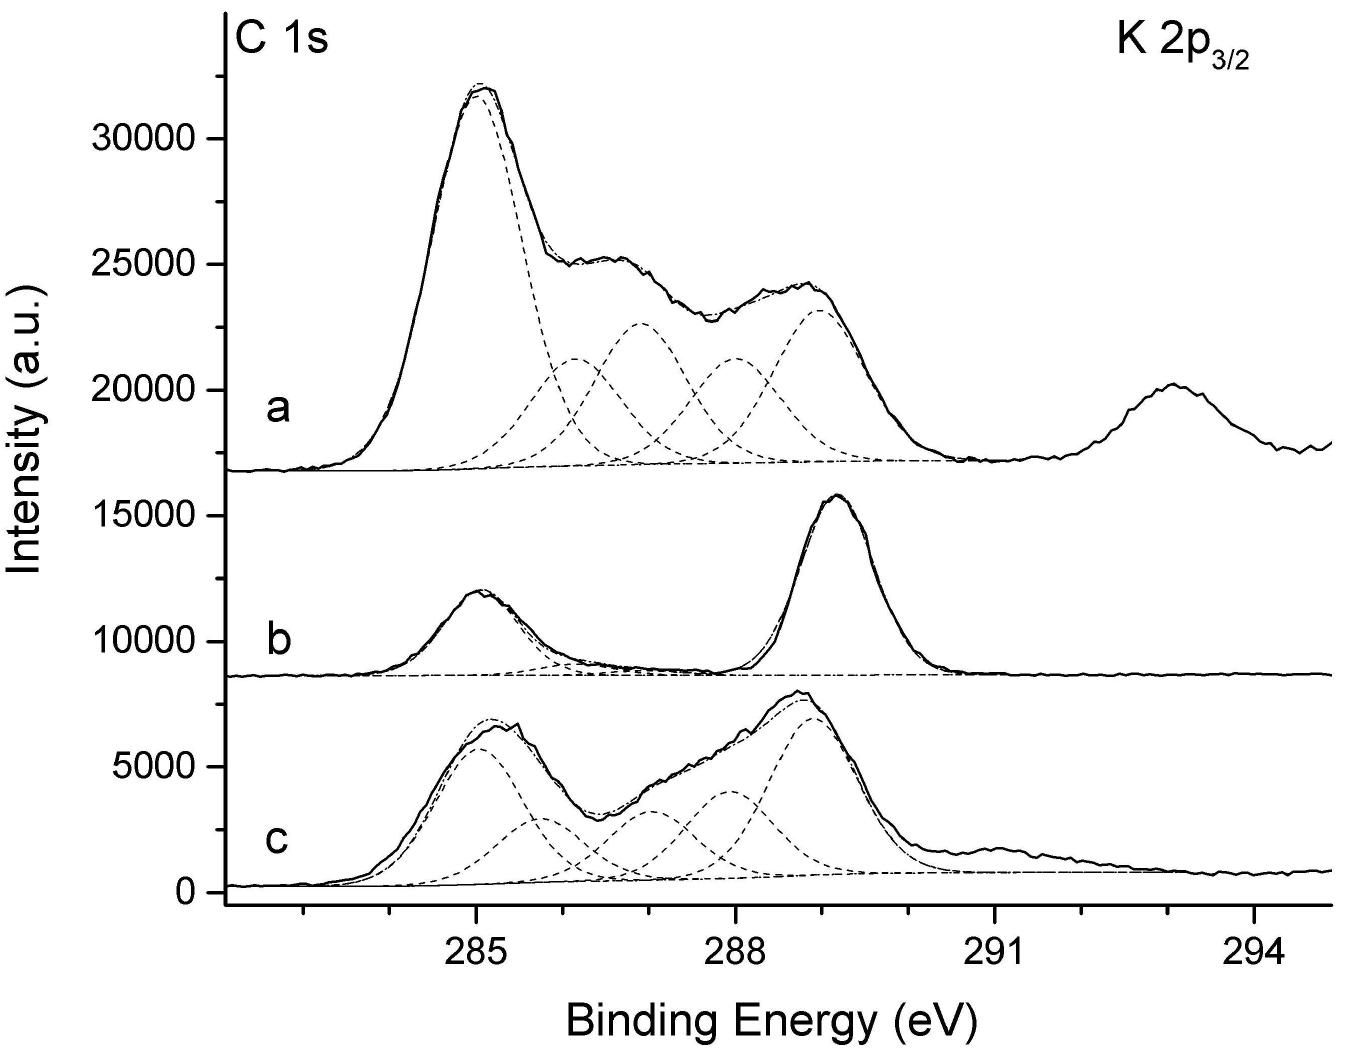
Fig 10. NormalisedC1s signal as obtainedby XPS for the fishinglines of droplet sample 1 (a), urea powder(b), and uric acid powder (c).